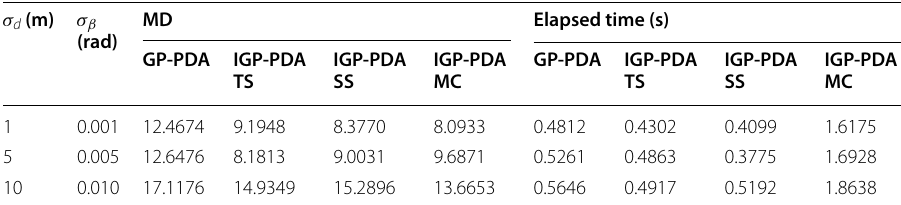
Table 7 Effect of measurement noise on contour estimates MD and elapsed time in the second scenario